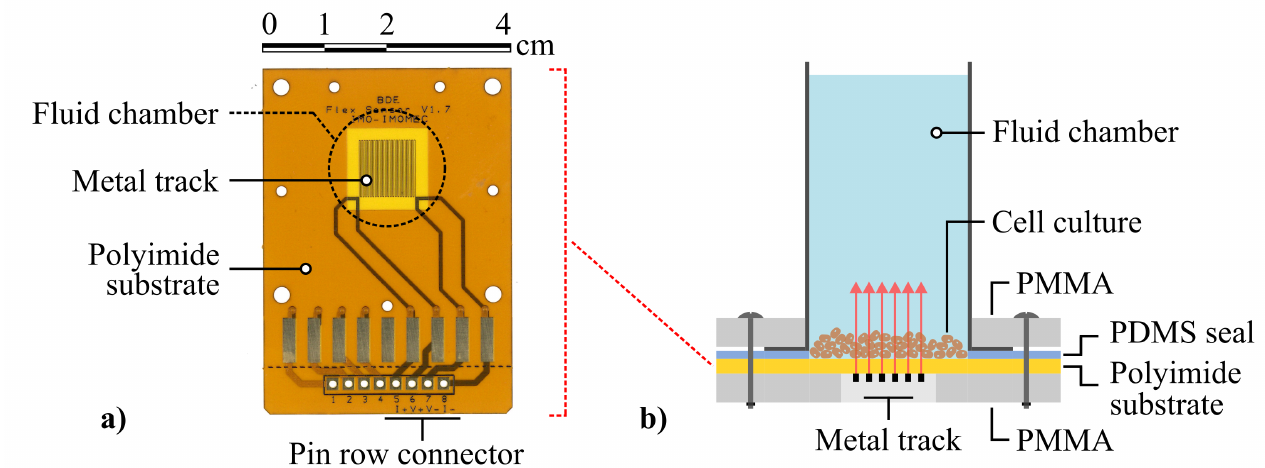
Figure 2. ( a ) An image of the sensor used for the detection of cells containing a metal track deposited on the polyimide substrate. ( b ) Schematic representation of the experimental setup during measurement of a cell layer. Heat pulses propagating from the heating structure through the cell layer and growth medium are represented by the red